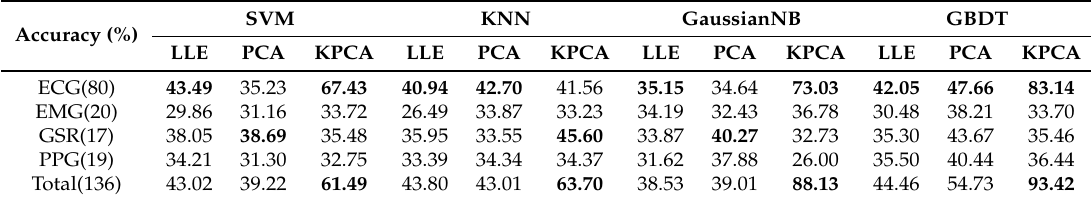
Table 5. Classification results of different models on the features of each signal.